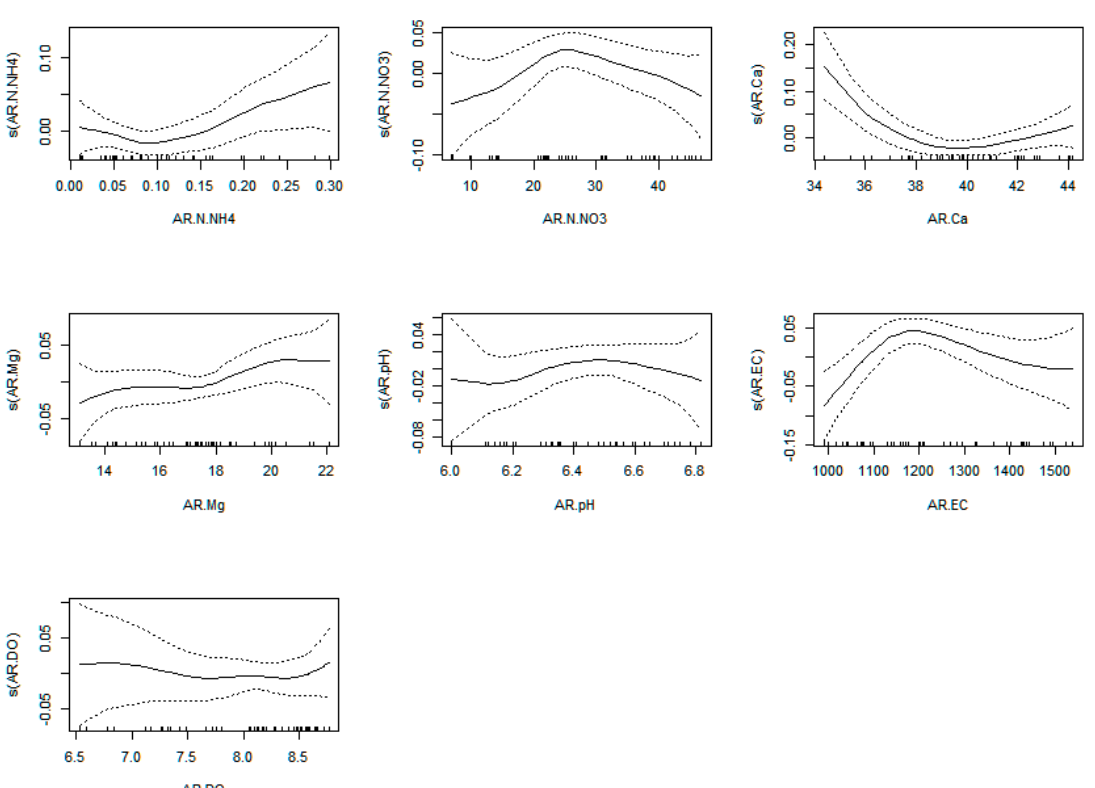
Figure A22. The GAM predictors influence over N-NO 2 for AH experimental variant.